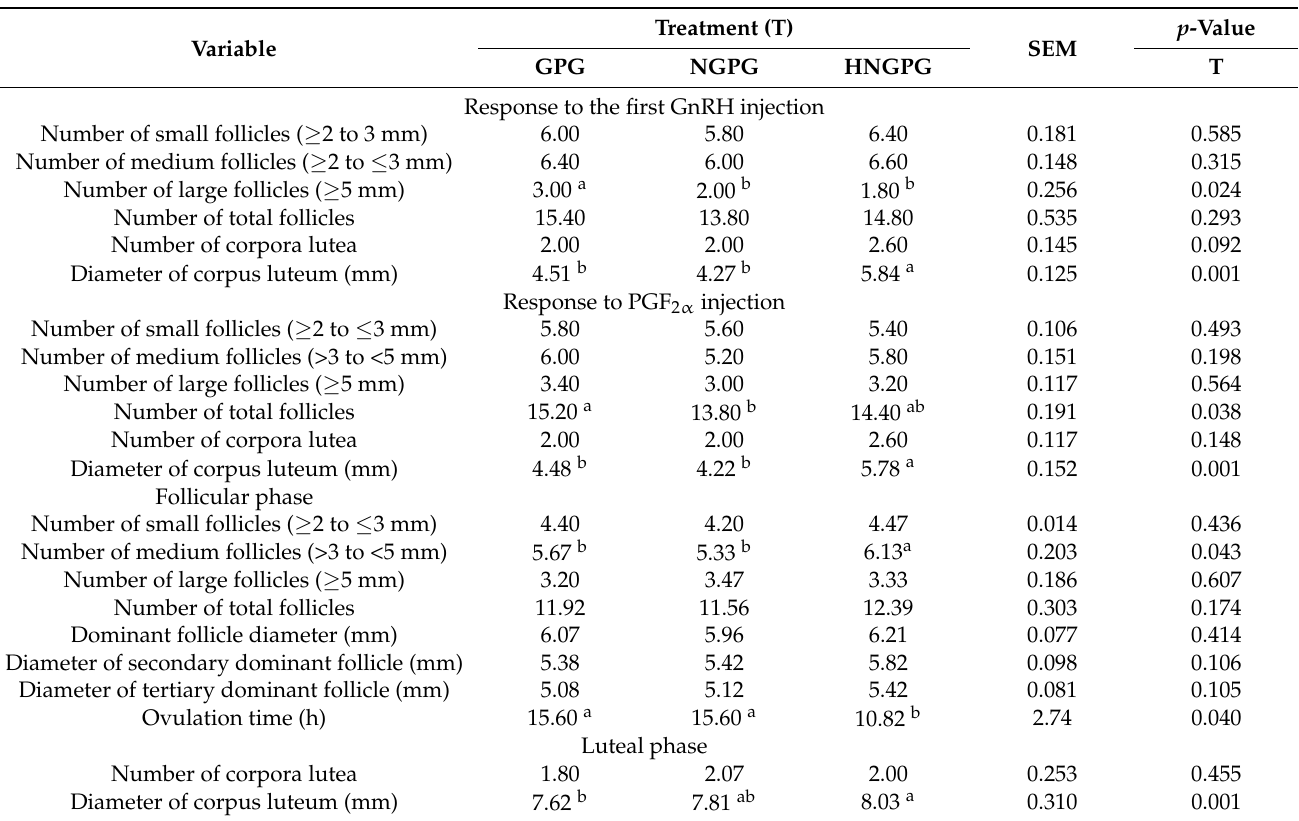
Table 2. Ovarian response to Ovsynch protocol using conventional hormones (GPG: 50 mg